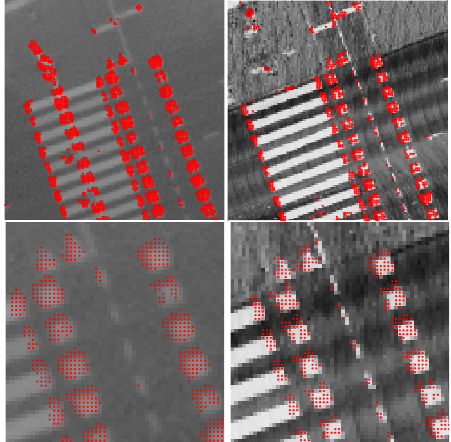
Figure 15. Adaptive Harris corner feature detection from aerial (left) and MLSPC (right) image patch 1